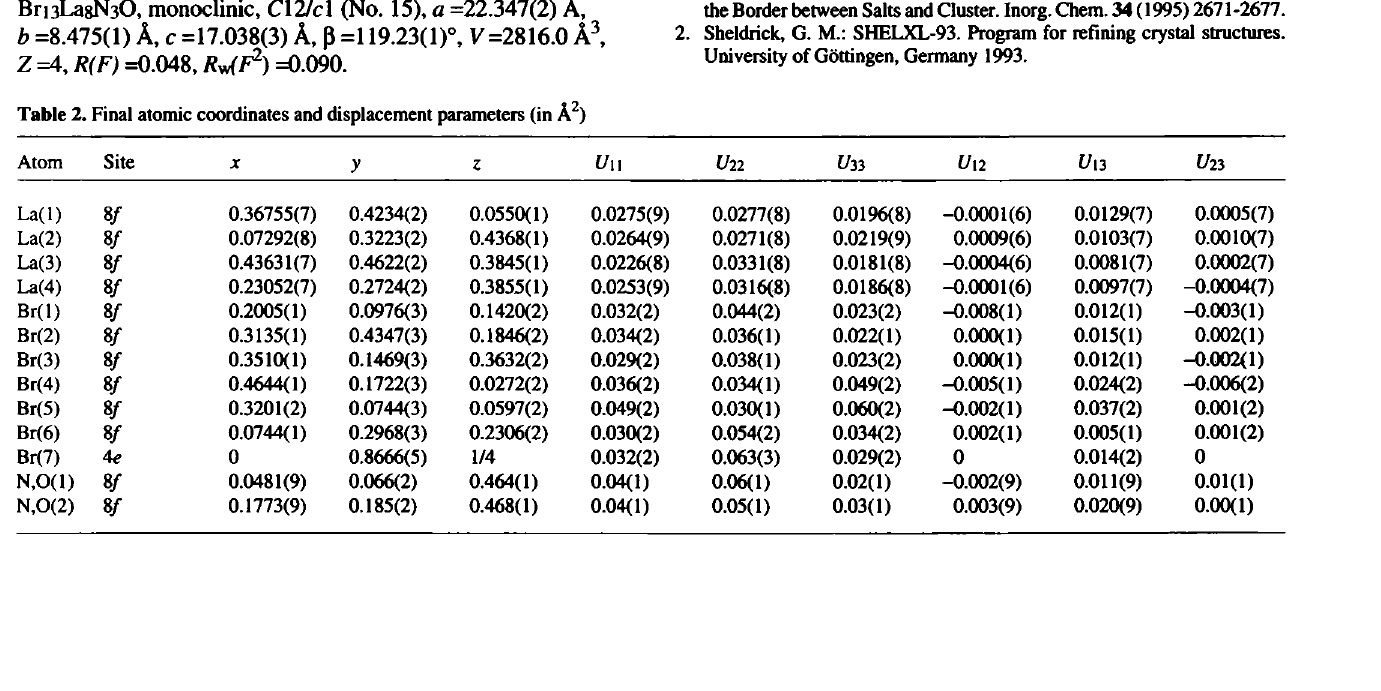
Table 2. Final atomic coordinates and displacement parameters (in